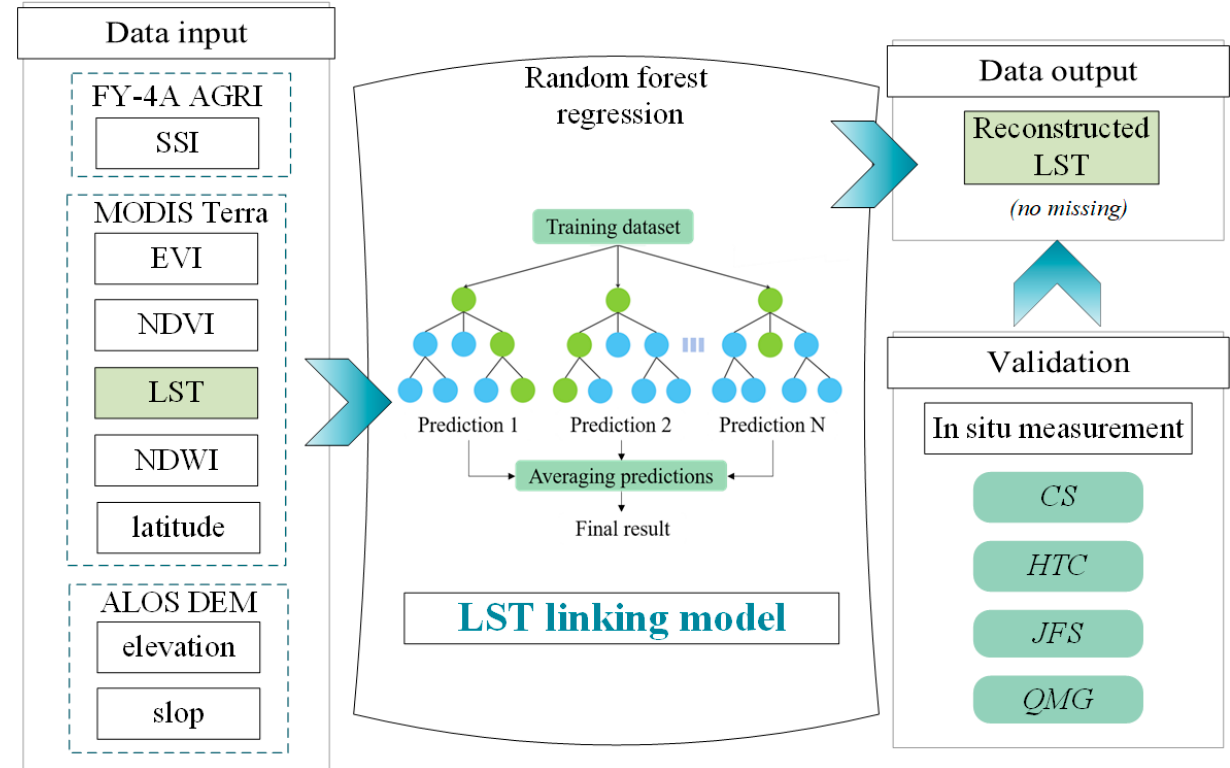
Figure 2. Flowchart of the LST reconstruction process for cloudy pixels.